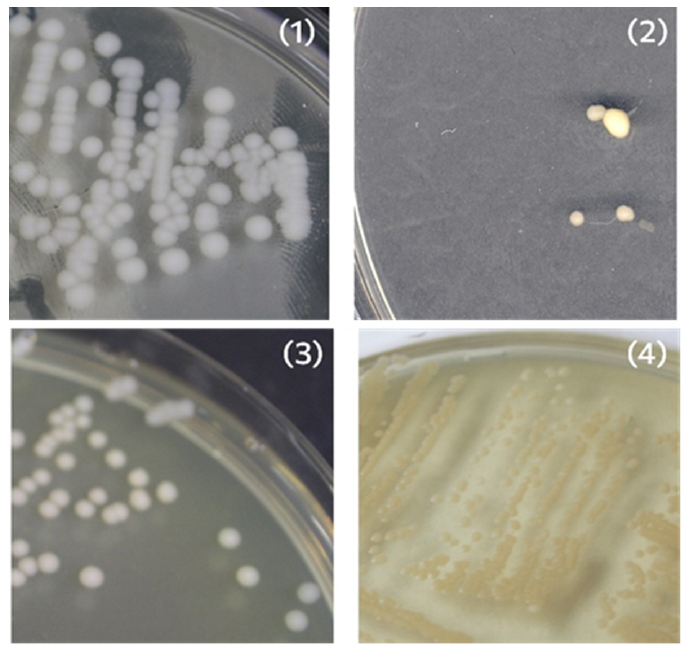
Figure 6. Bacterial colony-forming units Candida parapsilosis ATCC90018 ( 1 ), Neurospora crassa ( 2 ), Escherichia coli U20 ( 3 ) and Staphylococcus aureus CSA154 ( 4 ).